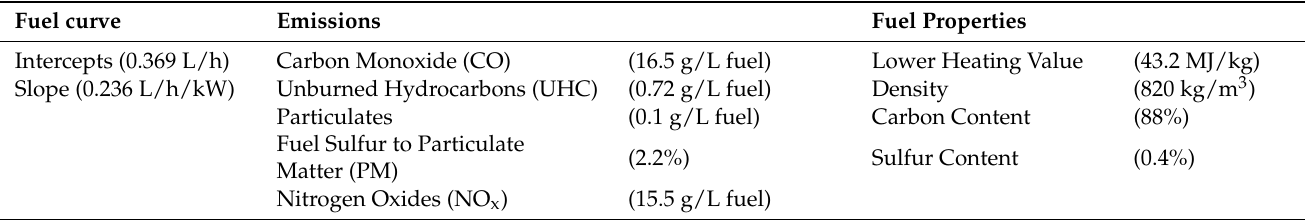
Table 4. Auto-size genset default